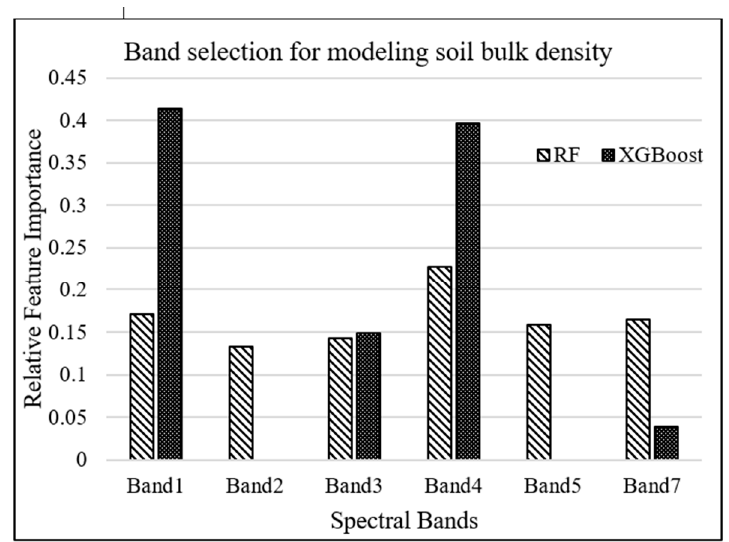
Figure 3. Relative importance of Landsat-7 bands for modeling bulk density.